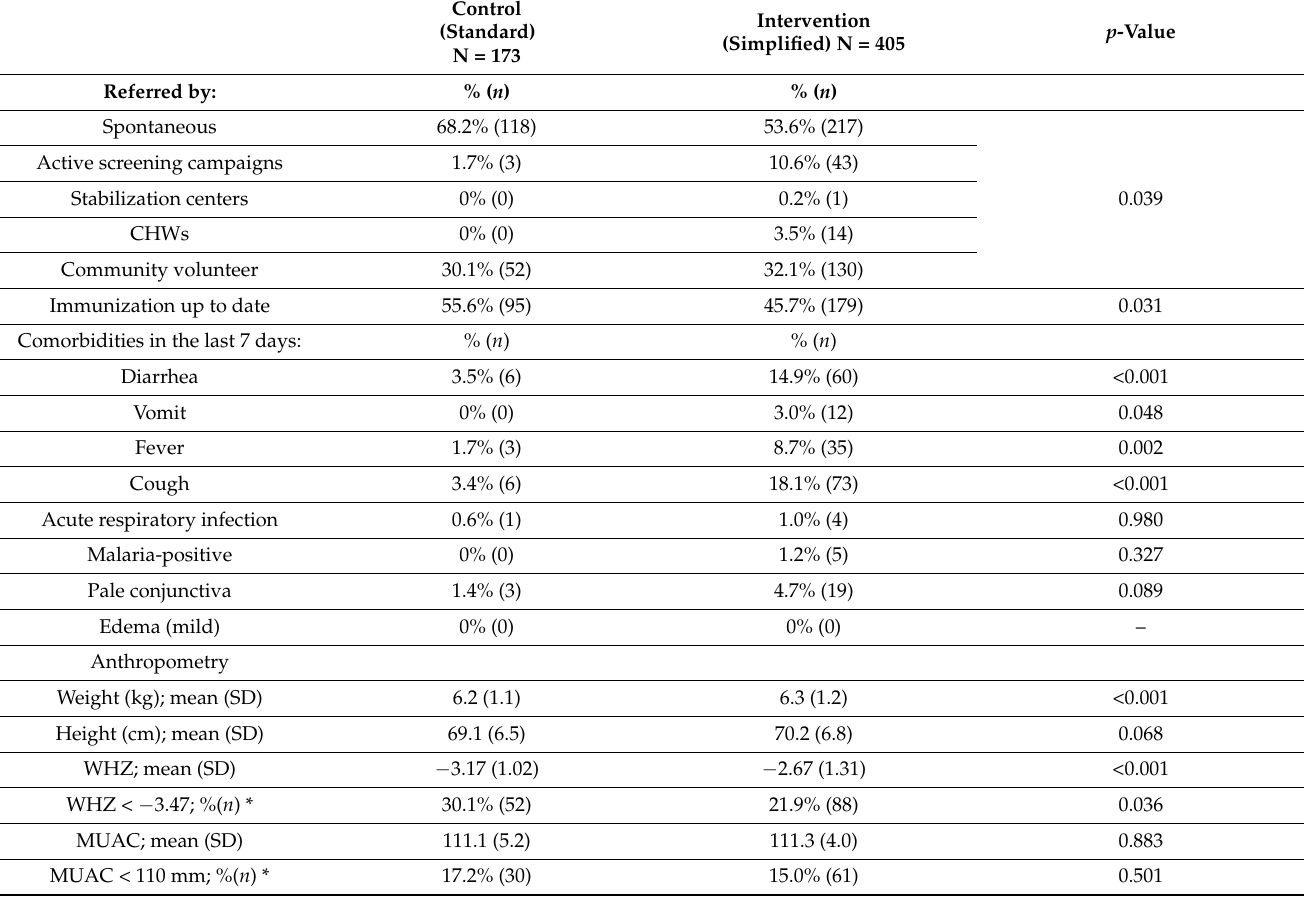
Table 3. Characteristics of cases at admission for severe acute malnutrition treatment, compared by study group.